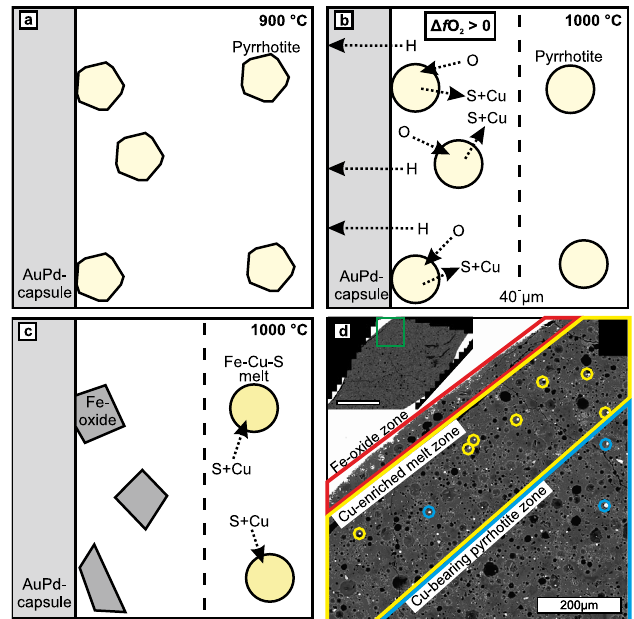
Fig. 5 A schematic model for the formation of the Cu-rich sulphide melts in the 1000 °C experiment. a At 900 °C, the Cu-bearing pyrrhotite is stable. b At 1000 °C, loss of H through the Au 90 Pd 10 capsule wall causes increase in oxygen fugacity in narrow zone close to the capsule wall. The increasing oxygen fugacity increases stability of Fe-oxide and consequently pyrrhotite within the oxidized zone becomes unstable. As the pyrrhotite oxidizes, S and Cu partition into the fl uid phase. c Fe-oxide replaces pyrrhotite close to the capsule wall. The S – Cu-bearing fl uid migrates to the more reduced center of the capsule and reacts with pyrrhotite. The Cu-rich sulphide melt forms when the Cu content of the pyrrhotite increases. d Spatial distribution of Fe-oxide grains (red rectangle), Cu-rich sulphide melt droplets (yellow circles), and Cu-bearing pyrrhotite grains (blue circles) within the portion of the 1000 °C experiment capsule (green rectangle) shown in the top left corner (scale bar 1 mm). Only the sulphide grains with measured compositions are indicated with